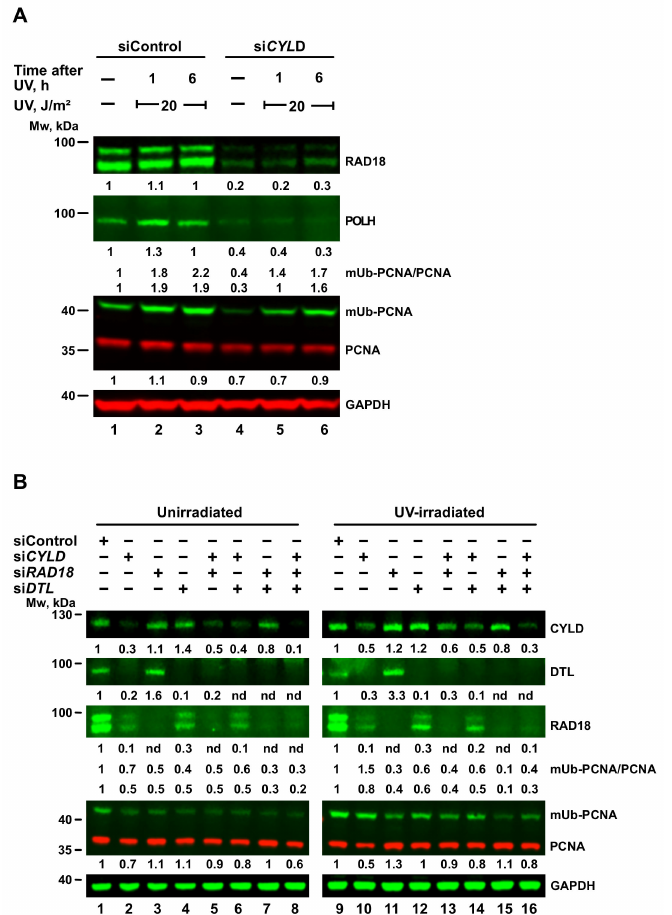
Figure 5. Effect of CYLD on RAD18, DTL, POLH and PCNA monoubiquitination. ( A ) MCF-7 cells were transfected with CYLD -targeted siRNA (si CYLD ) or siControl. At 65 h post-transfection, the cells were irradiated at 20 J/m 2 UV and harvested 1 or 6 h post-irradiation. ( B ) MCF-7 cells were transfected with siRNA against CYLD , RAD18 and DTL or their double or triple combinations. At 65 h post-transfection, the cells were UV-irradiated at 20 J/m 2 and harvested 6 h post-irradiation. Whole-cell extracts were fractionated by SDS-PAGE and analyzed by Western blot with indicated antibodies. Protein levels were normalized to GAPDH and presented each relative to its level in unirradiated or UV-irradiated siControl-treated